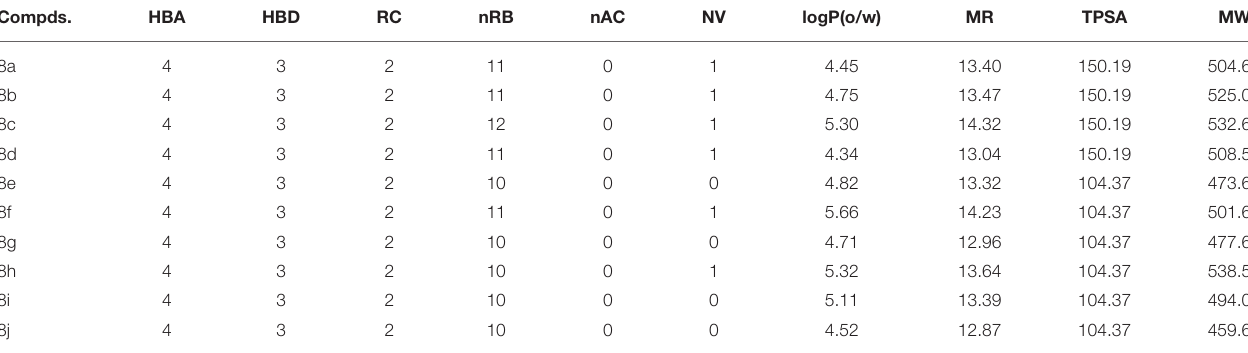
TABLE 1 | Physicochemical properties of the compounds. Compds.